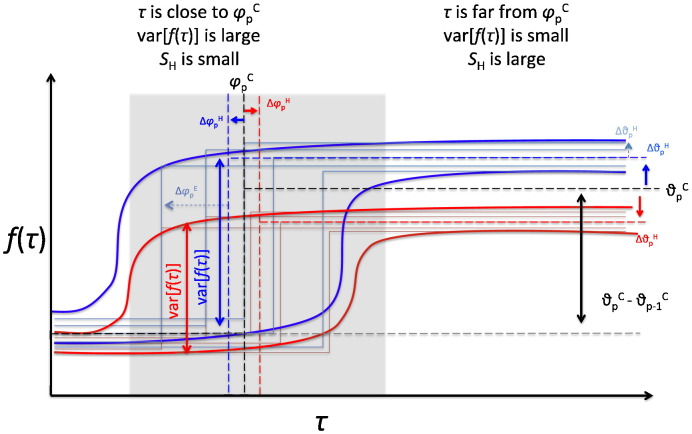
A toy illustration of the fluctuations of variance. Two groups of networks (red and blue) with different topologies are shown around a core transition point, φpC with subject-specific and group specific offsets ΔφpE and ΔφpH, respectively. Bold lines indicate the variance of f(τ) for each group. The variance of f(τ) is inflated around φpC leading to low SH. As τ moves away from φpC, variance reduces and SH is larger, allowing the group differences to be identified.